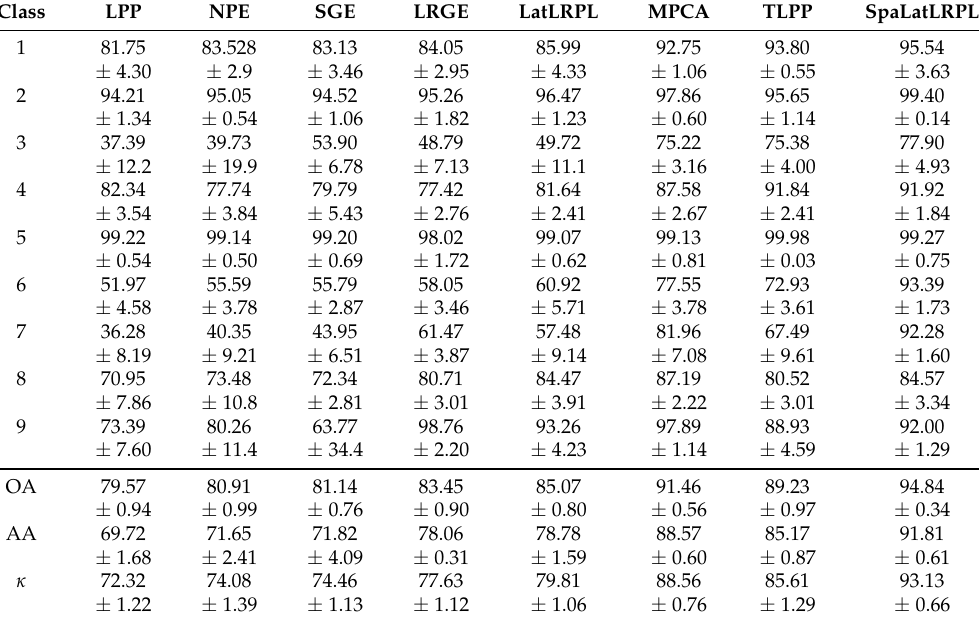
Table 2. The comparison of performance for all methods on the Pavia University